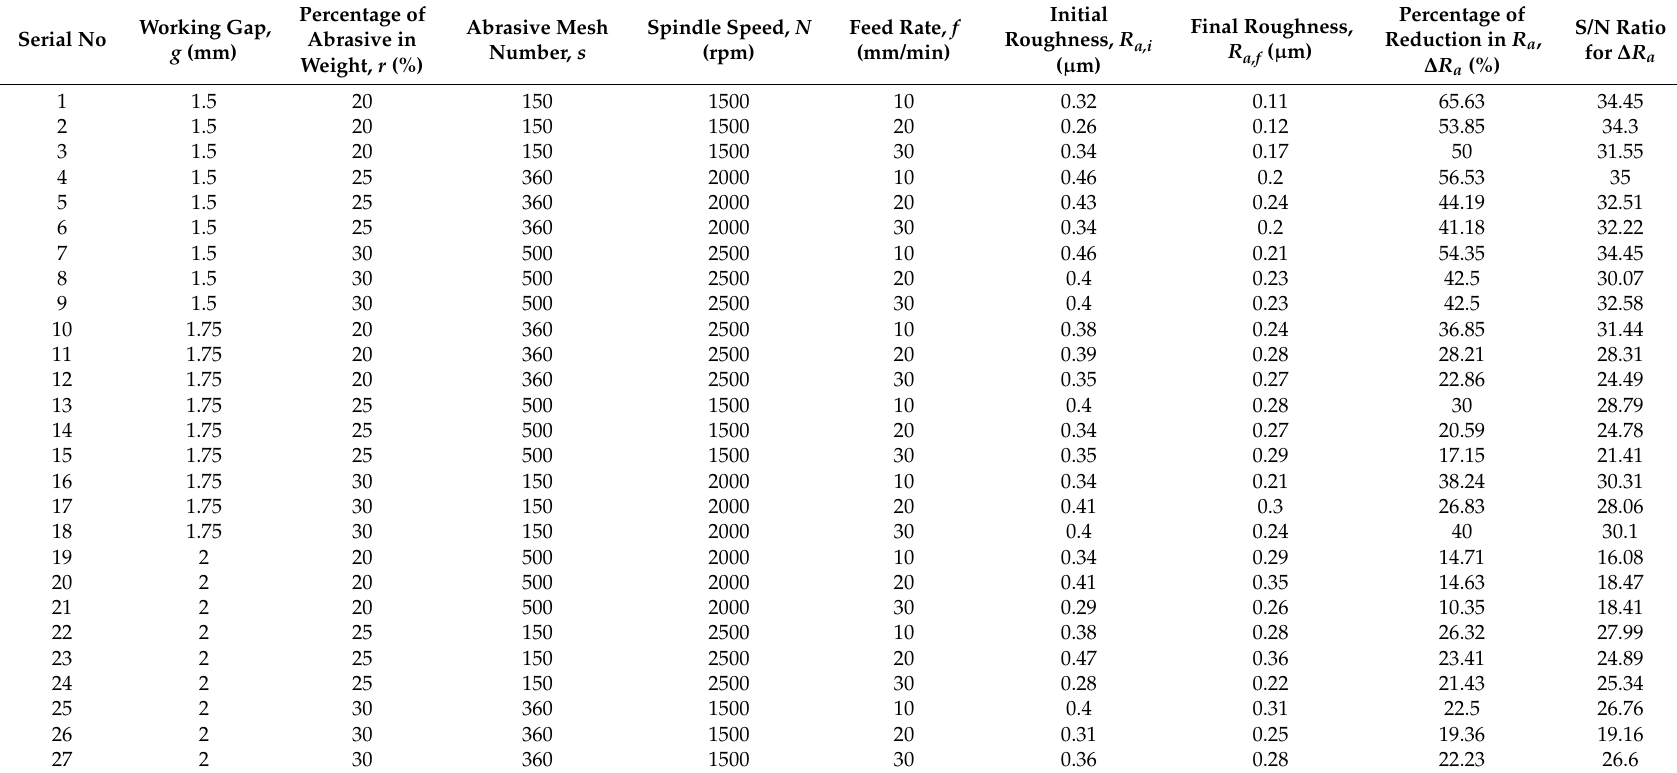
Table 4. Roughness results and estimated S/N ratios of ∆ R a (%) for MAF with Al 2 O 3